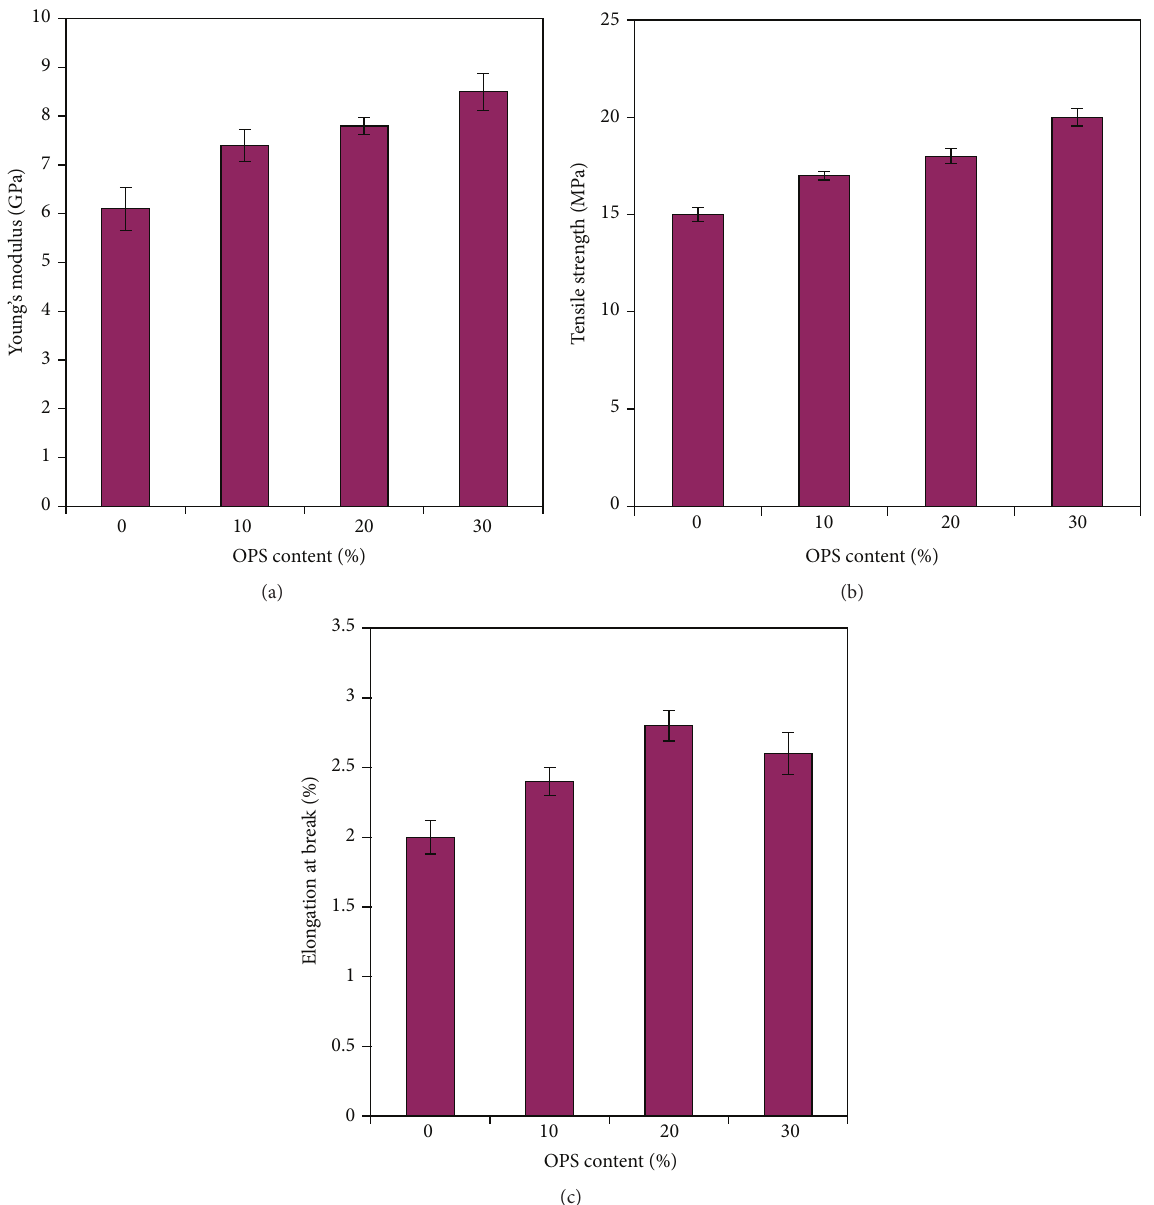
Figure 1: Mechanical properties results of UPE/OPS composites: (a) Young’s modulus, (b) tensile strength, and (c) elongation at break.